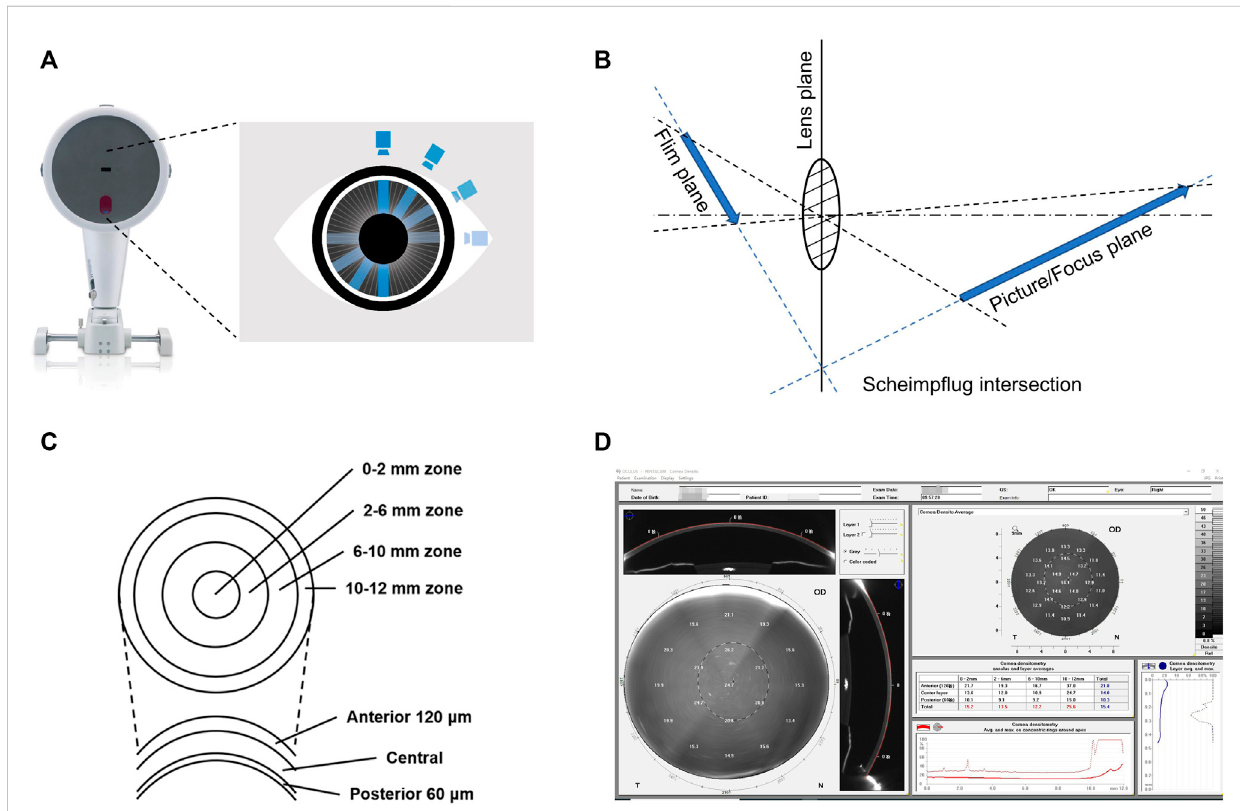
FIGURE 1 Measurement of corneal optical density by the Pentacam Scheimp fl ug imaging system. (A) Schematic representation of the rotation of the Scheimp fl ugcameraofthePentacamScheimp fl ugimagingsystem. (B) SchematicrepresentationoftheScheimp fl ugprinciple.Itsmainfeatureisthatthe plane of the fi lm, the lens, and the picture/focus plane cut each other in a Scheimp fl ug intersection. Thus, the focused region is increased, and the sharpness of the image is improved. (C) Schematic representation of the corneal zones and layers de fi ned by the Pentacam Scheimp fl ug imaging system. (D) Example of the software panel of the corneal optical densitometry in the Pentacam Scheimp fl ug imaging system. Displayed as a grayscale coded map, the average COD in different corneal zones and layers can be individually assessed and automatically displayed in the table